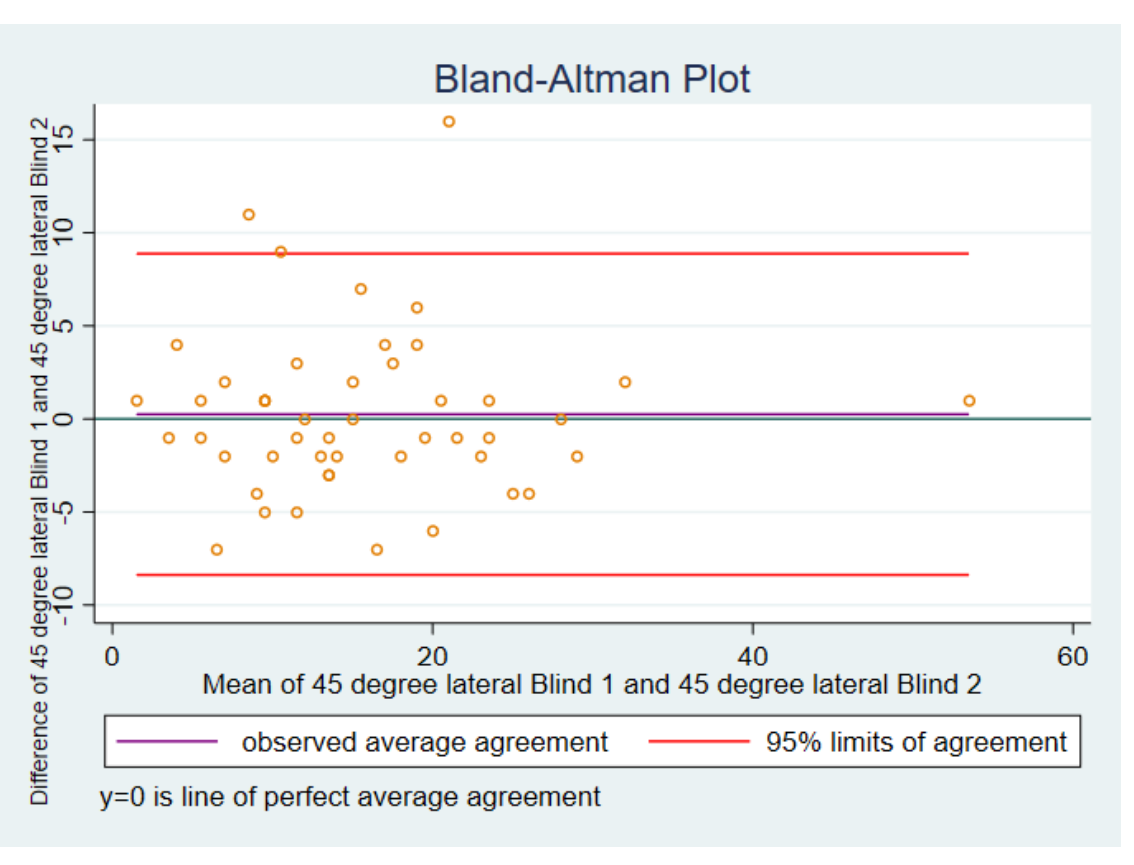
Figure A1. Forty-five degrees, lateral.